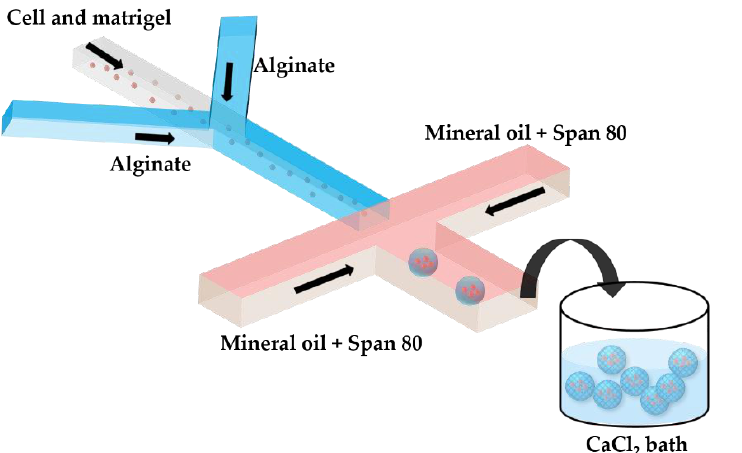
Figure 7. Production of alginate–Matrigel beads loaded with HeLa cells by off-chip external gelation in a gelation bath. The droplets containing HeLa cells, alginate, and Matrigel dissolved in a cell culture medium are generated in mineral oil containing 5 wt% Span 80, and are collected in a 4 wt% CaCl 2 solution. On-line tuning of the hydrogel composition is provided by supplying the two polymers via separate inlet channels, which allows for a flexible Matrigel to alginate the mixing ratio [42].